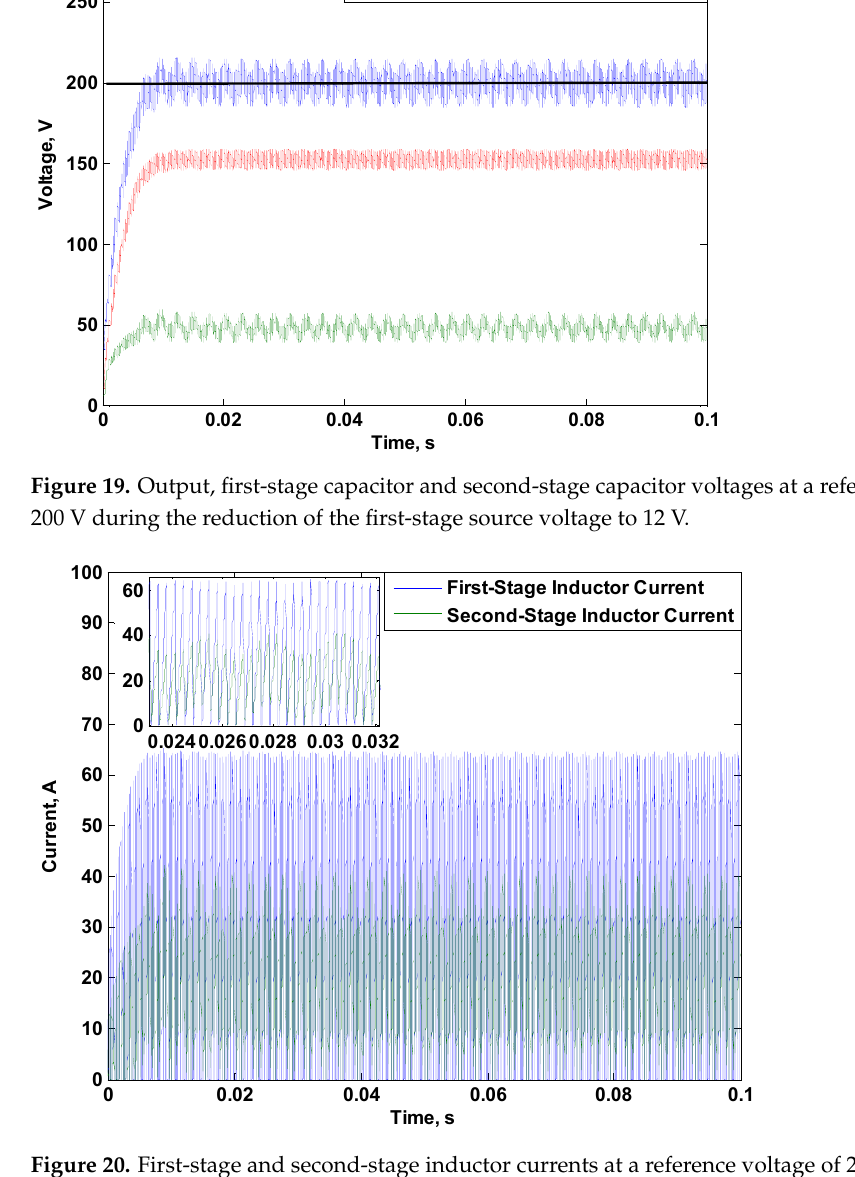
Figure 20. First-stage and second-stage inductor currents at a reference voltage of 200 V during the reduction of the first-stage source voltage to 12 V.